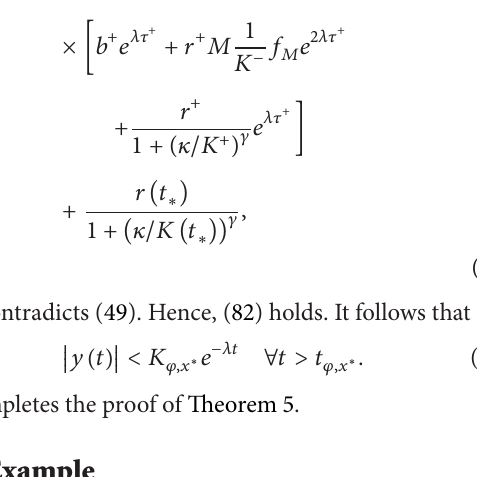
Figure 1: Numerical solution 𝑥(𝑡) of system (87) for initial value 𝜑(𝑡) ≡ 1,5, 8 .